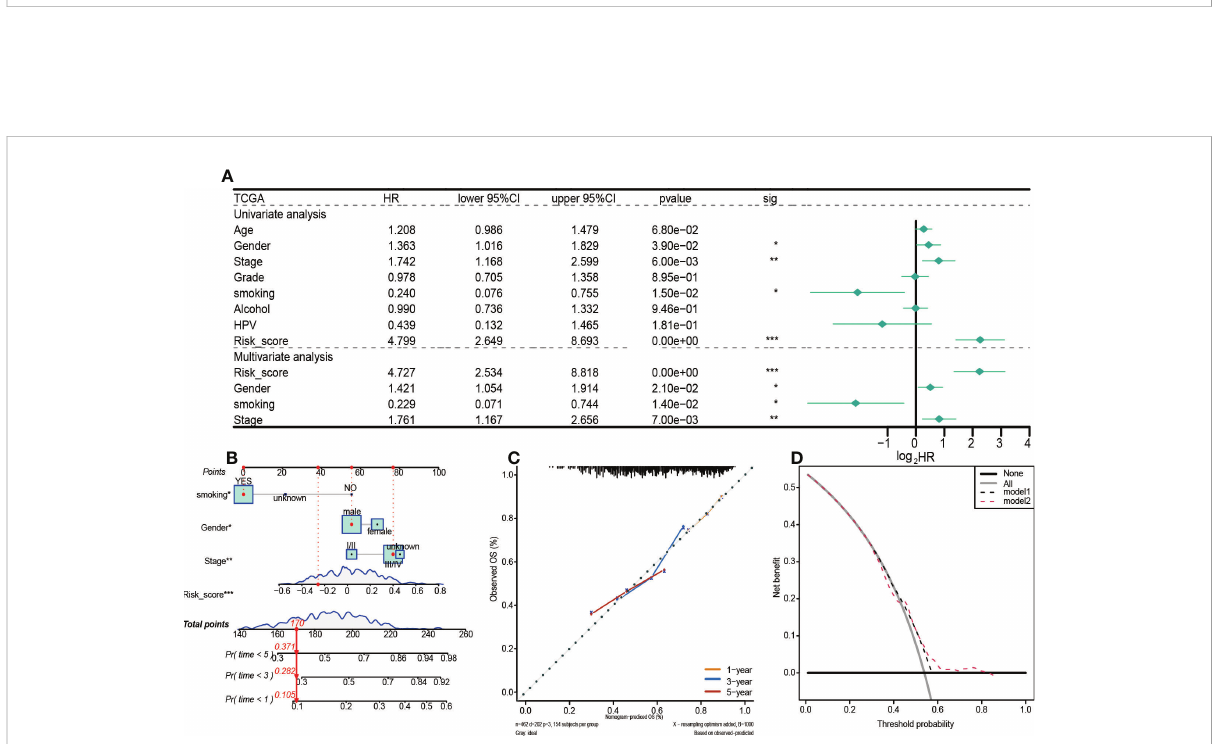
FIGURE 5 Prognostic values of the 5-gene signature model in the TCGA training set. (A) Results of univariate and multivariate Cox regression analyses regarding OS. (B) Nomogram for prediction of 1-year, 3-year, and 5-year survival probabilities of HNSCC patients. (C) Calibration curve for assessing the agreement between nomogram predicted and actual survival outcomes. (D) Assessment of the reliability of risk scores by DCA (decision curve). (*p < 0.05, **p < 0.01, ***p <